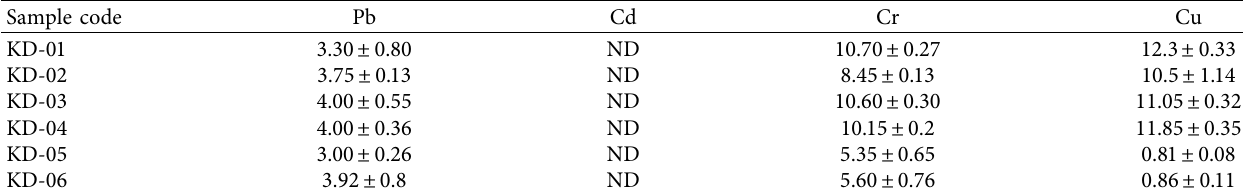
Table 3: Mean concentration of heavy metals in traditional herbal medicinal preparations (mean ± SD, n � 3, mg/kg dry weight). Sample